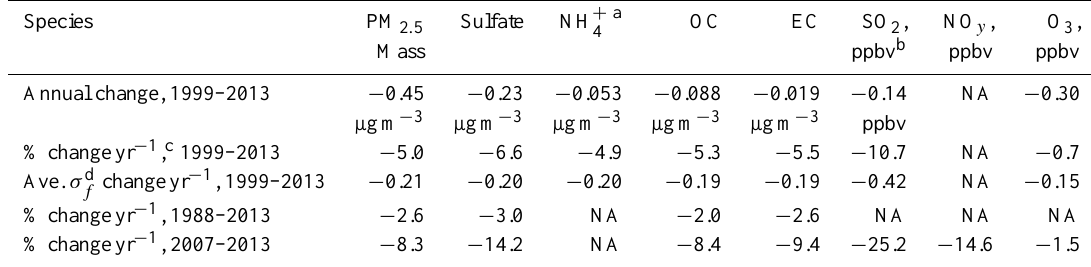
Table 2. Trends in annual concentrations of selected aerosol fine mass and gas species at Look Rock. Species